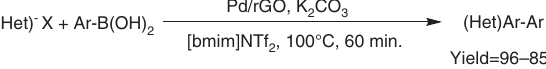
Scheme 3: Application of Pd/reduced graphene oxide (rGO) cata- lyst for Suzuki cross-coupling reaction in [bmim]NTf